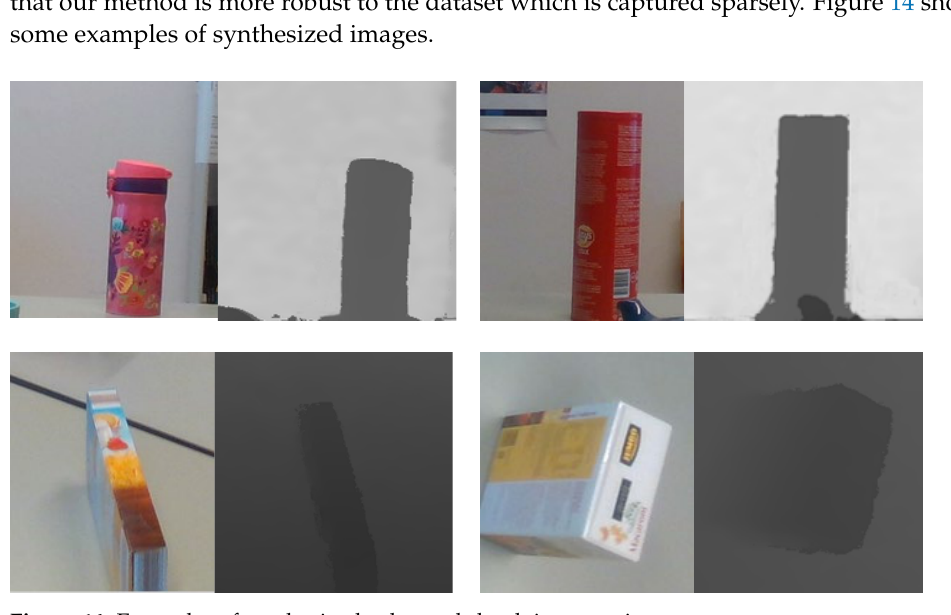
Figure 14. Examples of synthesized color-and-depth image